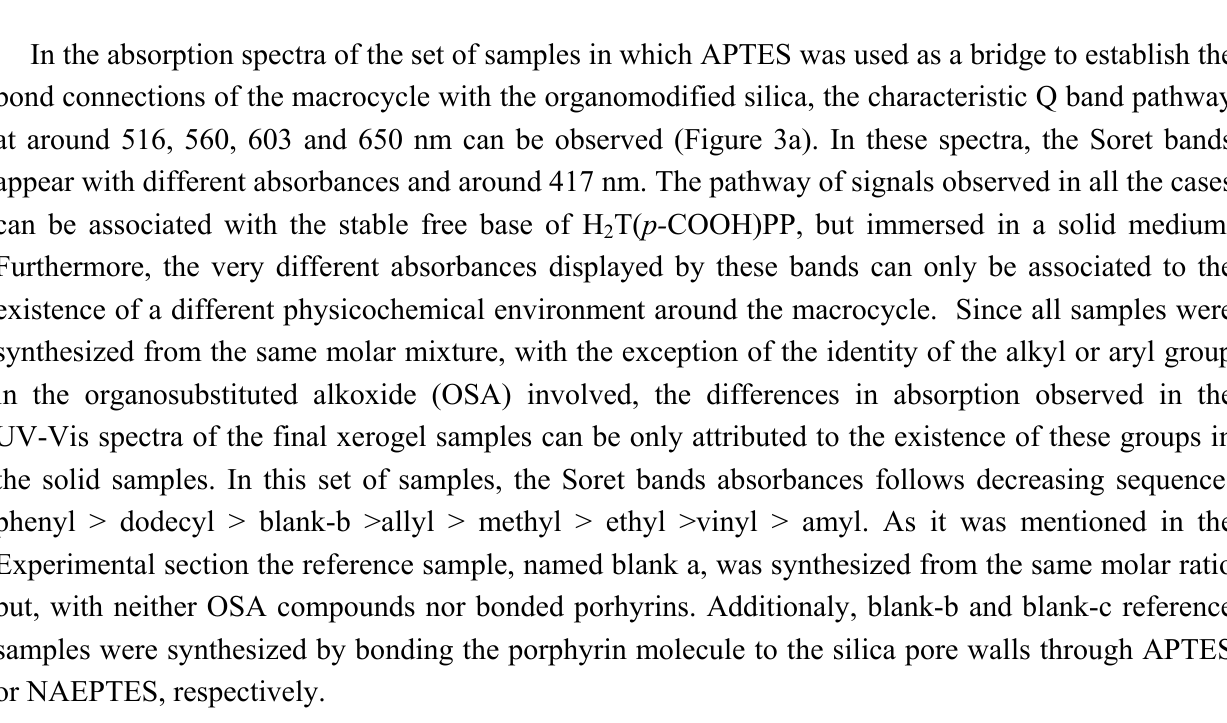
T( p- COOH)PP species covalently bonded, through 2 of f